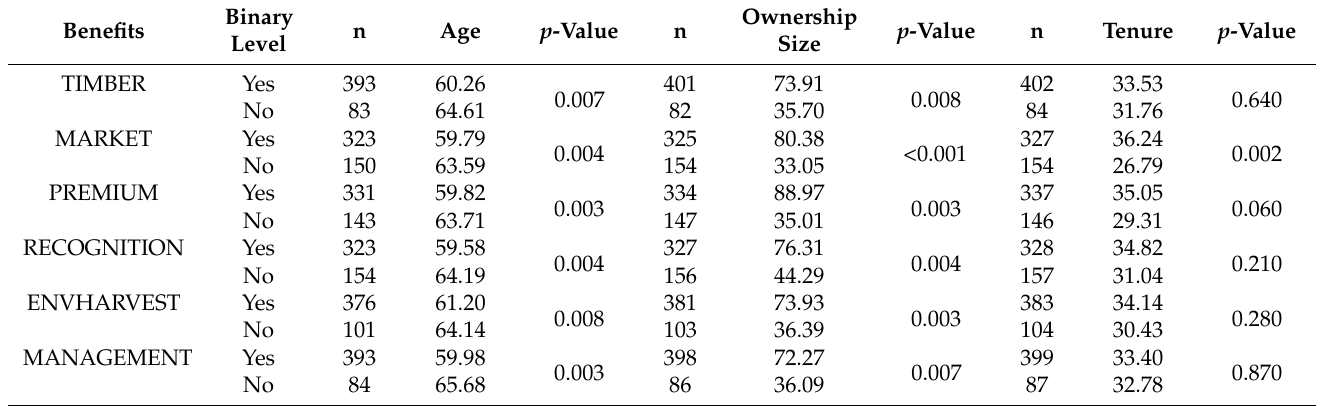
Table 2. ANOVA results for age, ownership size, and tenure with dependent